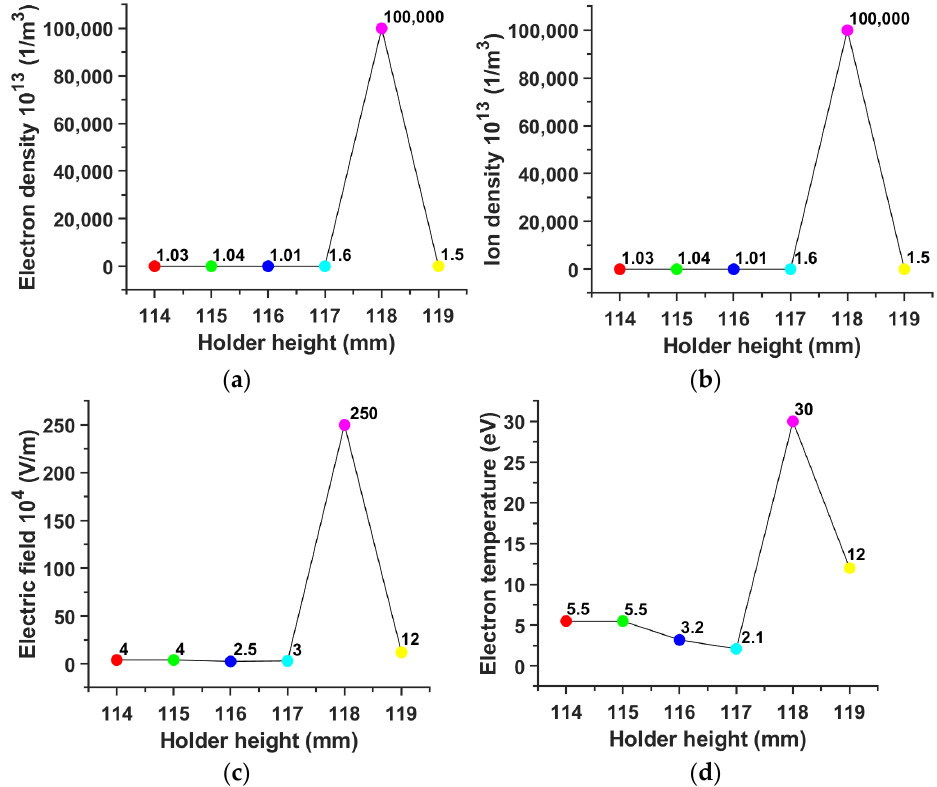
Figure 5. ( a ) Electron density, ( b ) ion density, ( c ) electric field, and ( d ) electron temperature are plotted as functions of the sample holder height at a microwave power of 700 W and gas pressure of 70 Torr in the MPJCVD system.